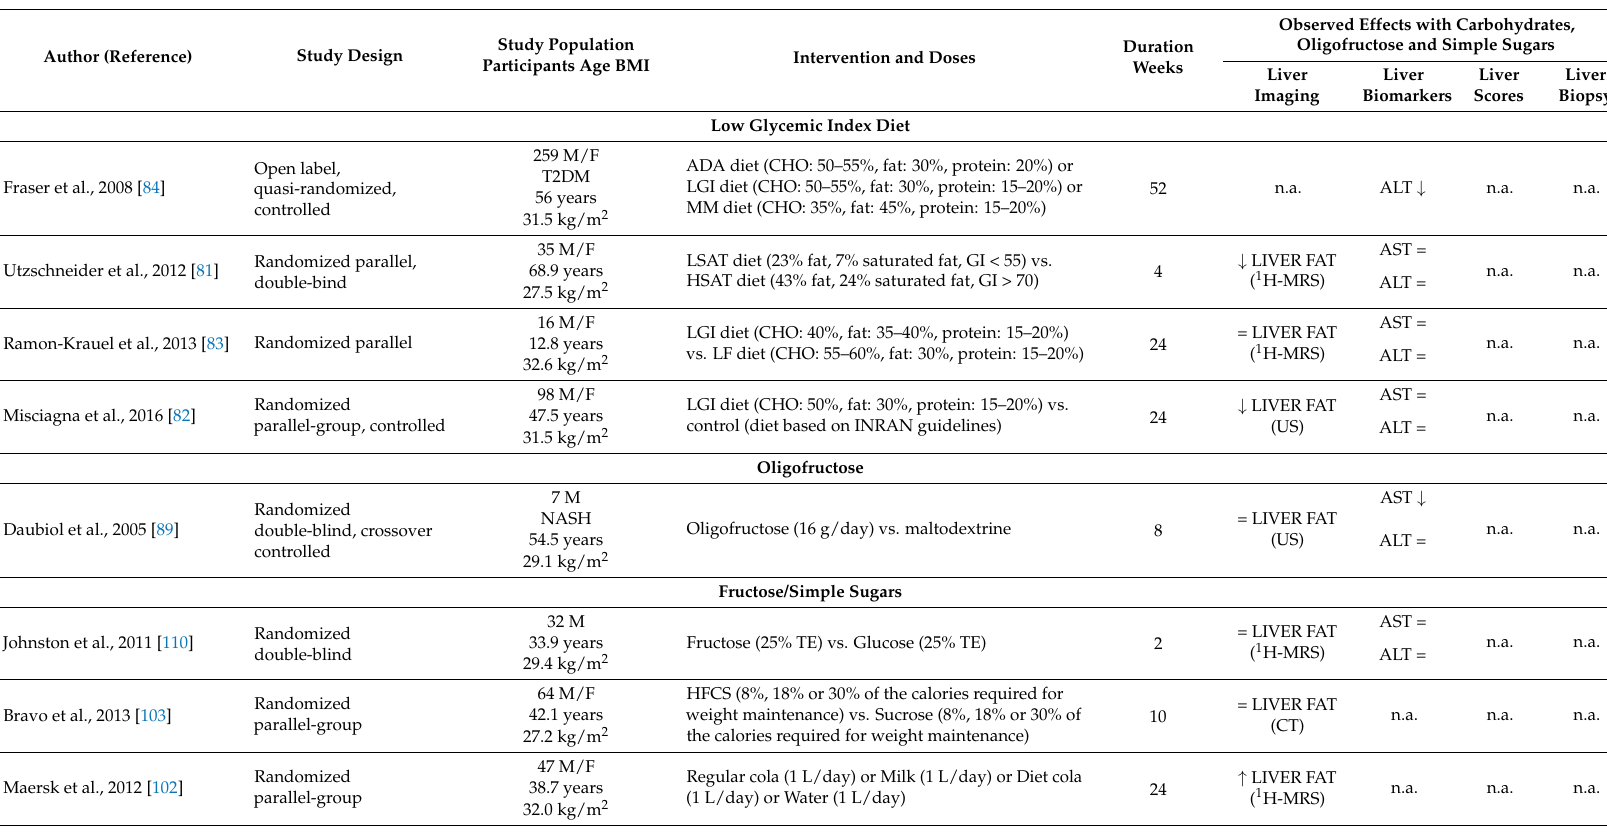
Table 3. Clinical trials on the effects of different types of carbohydrates (low glycemic index diet, oligofructose, and simple sugars) on NAFLD in individuals at high cardiometabolic